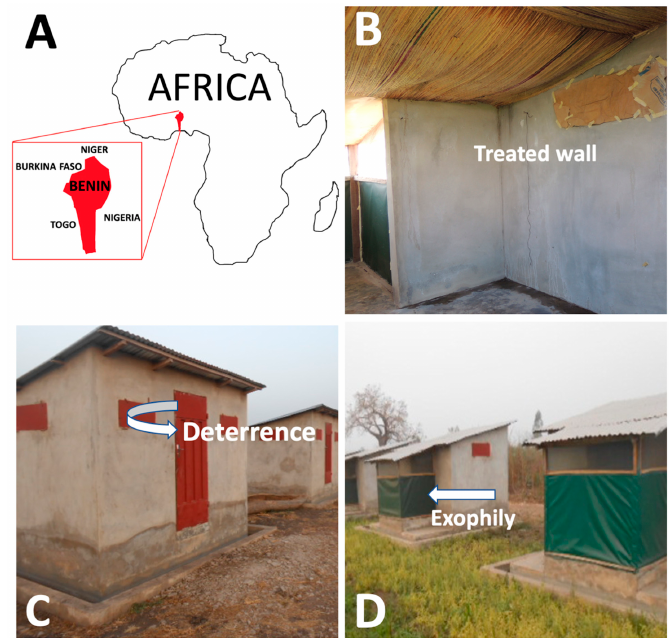
Figure 2. Study site and experimental huts: ( A ) location of field trial in Africa; ( B ) appearance of a treated wall; ( C ) front and side views of an experimental hut displaying the window slits for mosquito entrance as well as the movement of deterred mosquitoes; and ( D ) back view of a hut displaying the veranda trap as well as the exophily movement of mosquitoes that had entered the hut.